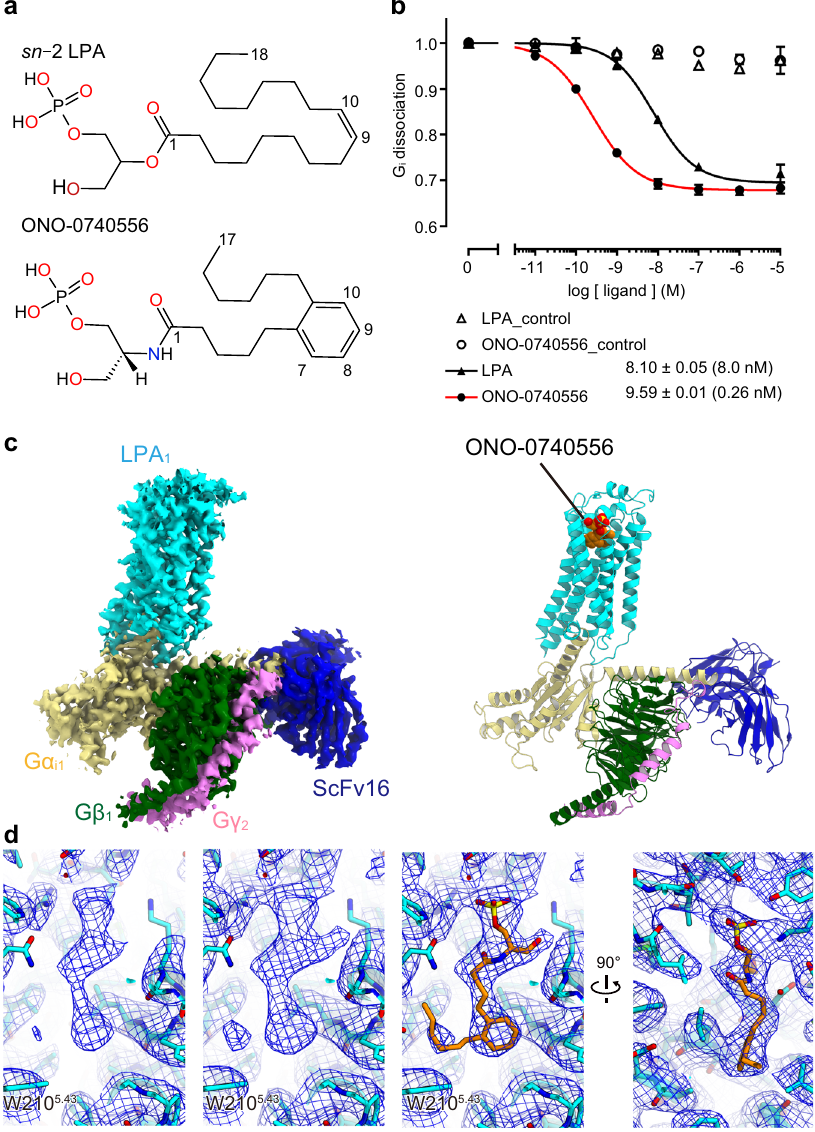
Fig. 1 | Overall structure of the LPA 1 -G α i1 β 1 γ 2 -ScFv16 complex. a Chemical structures of LPA and ONO-0740556. b Ligand-induced G i activation by LPA 1 -G i activation was measured by the NanoBiT-G-protein dissociation assay. Concentration – responsecurvesareshownasmeans±s.e.m.(standarderrorofthe mean) from three independent experiments. Sourcedata are provided asa Source